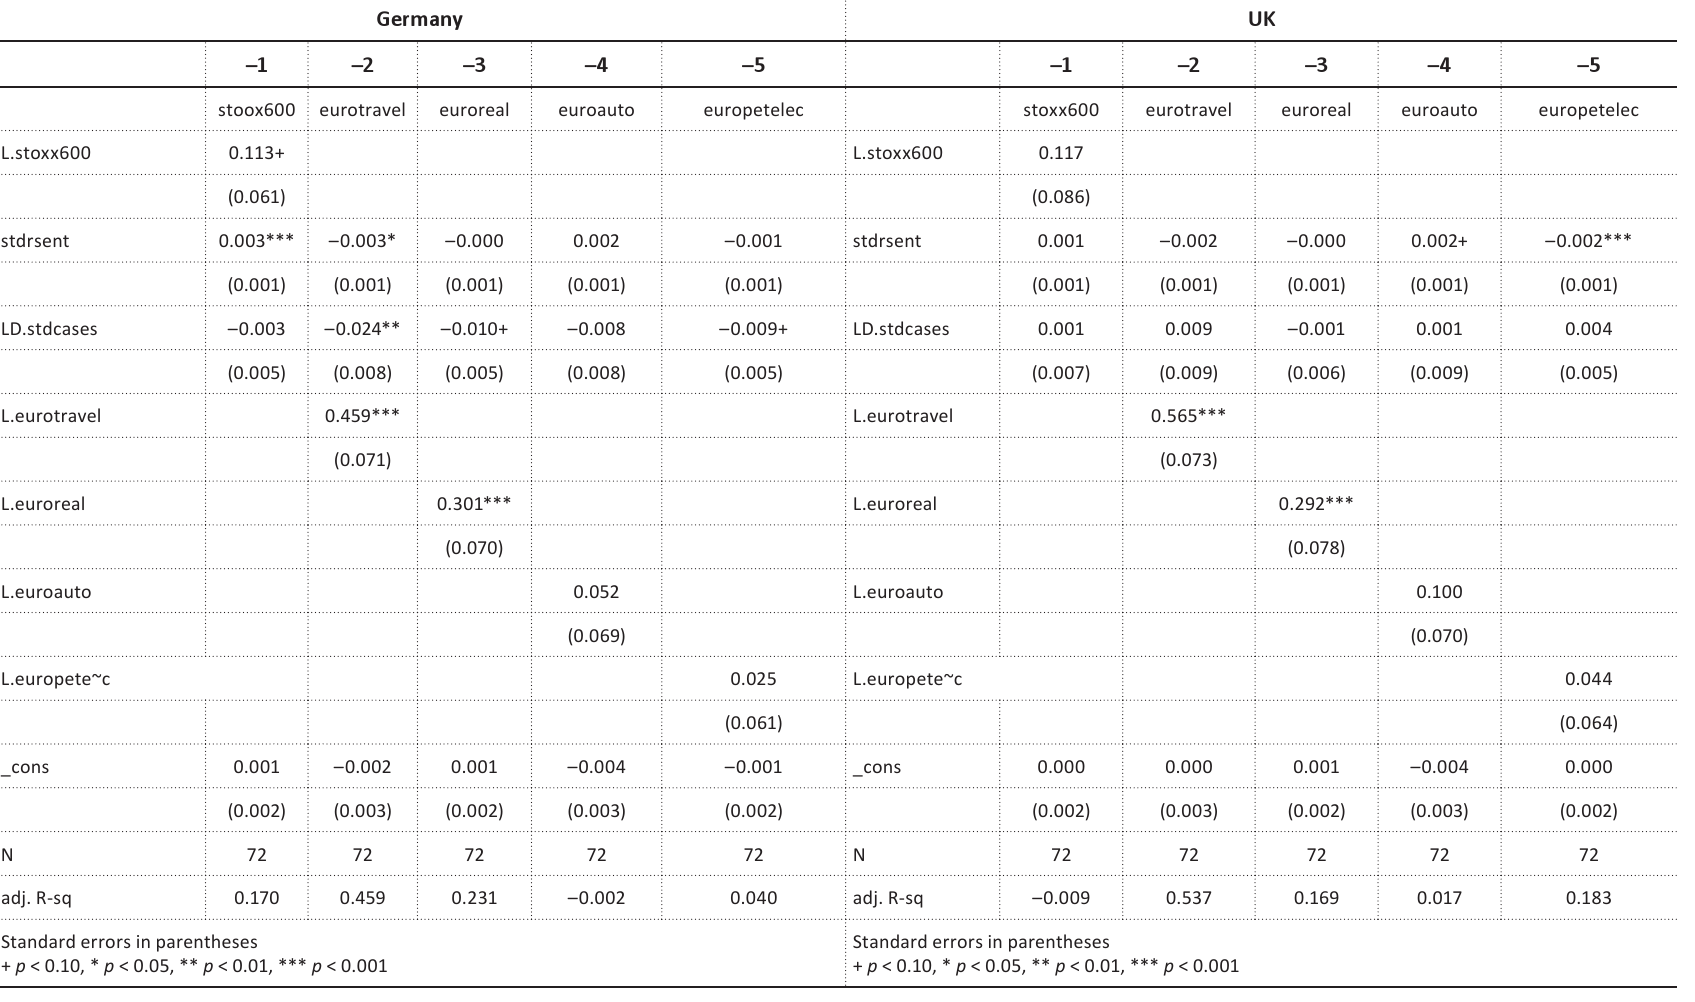
Table 5. OLS robust regressions for Germany and